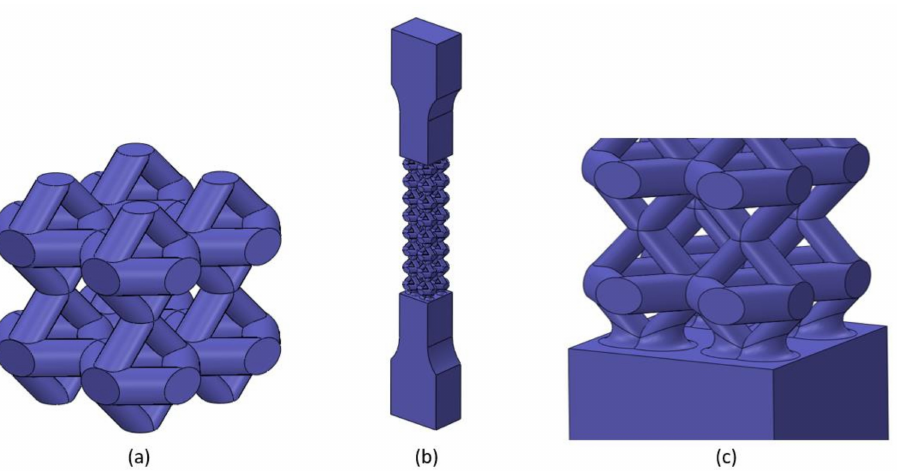
Figure 2. Computer-aided design models (CAD) of the Space-Claim diamond lattice structure parts: